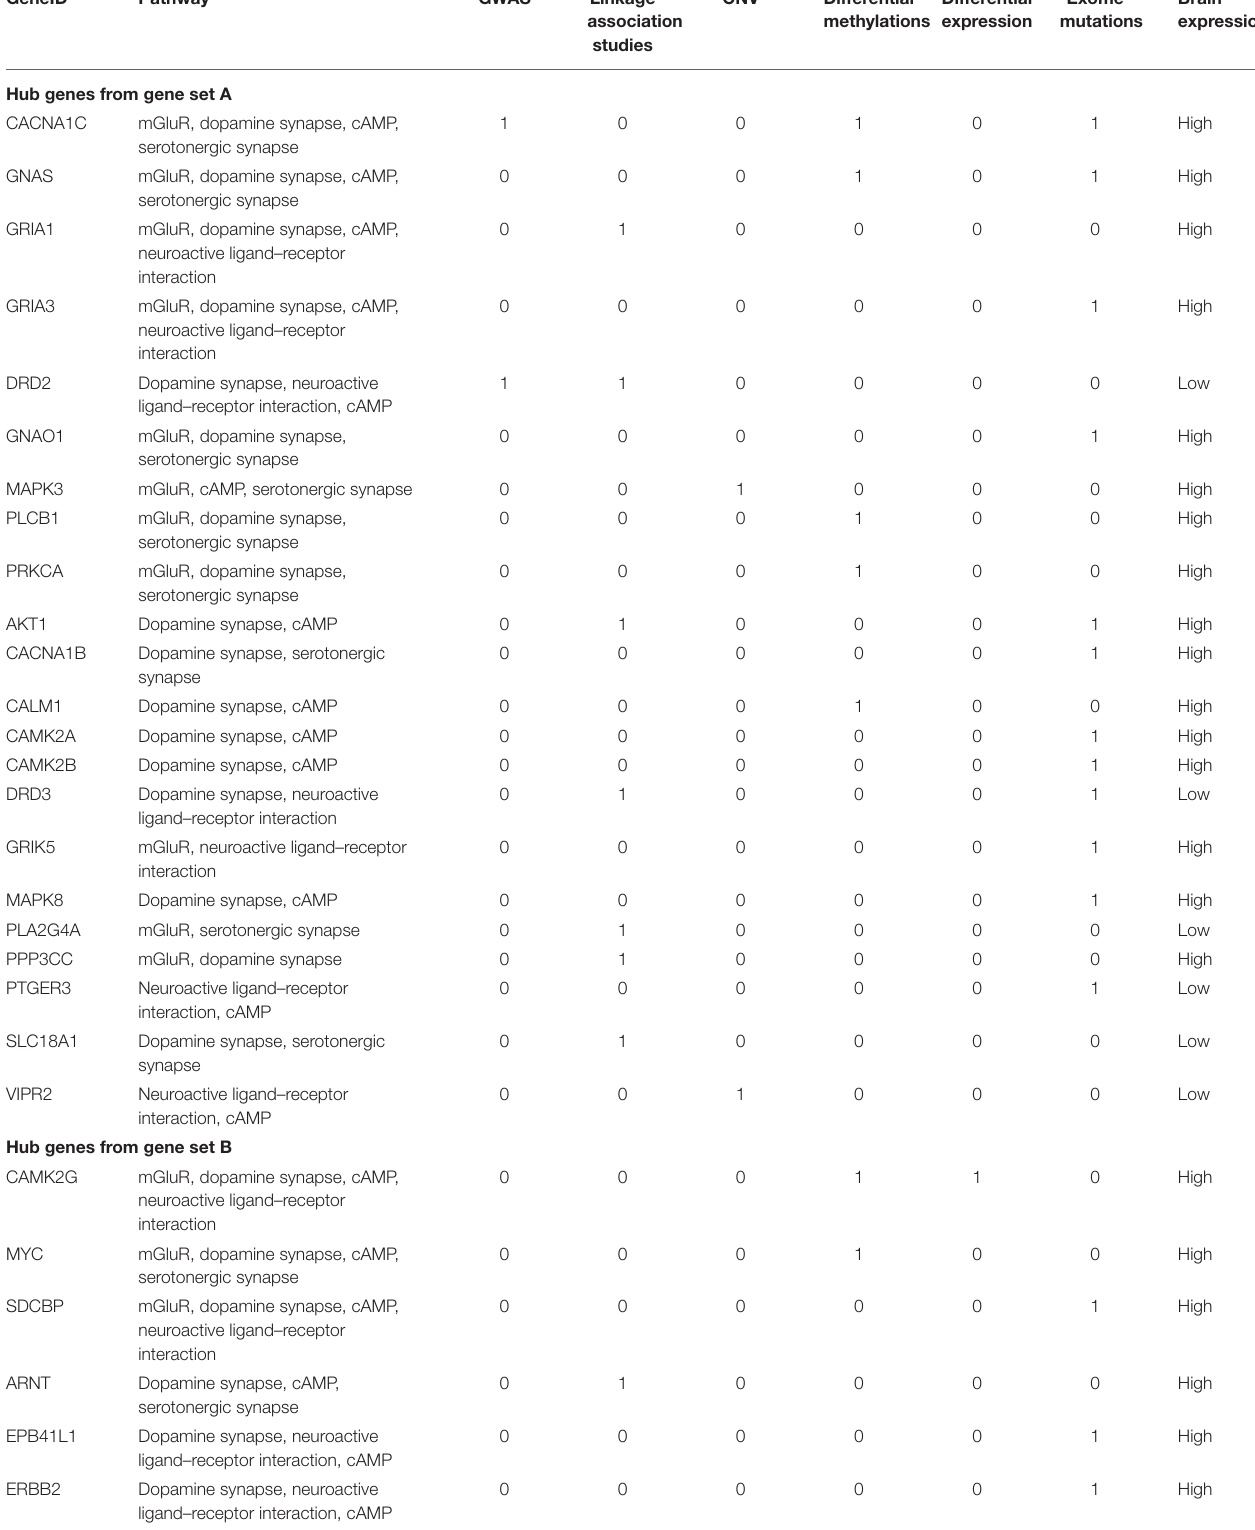
CNV Differential Differential Exome Brain association methylations expression mutations expression studies